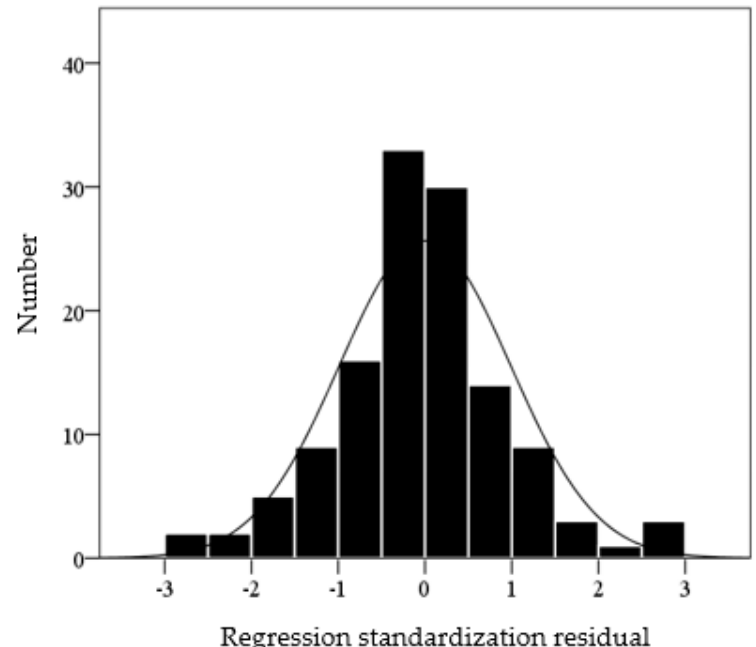
Figure 9. Residual distribution histogram.